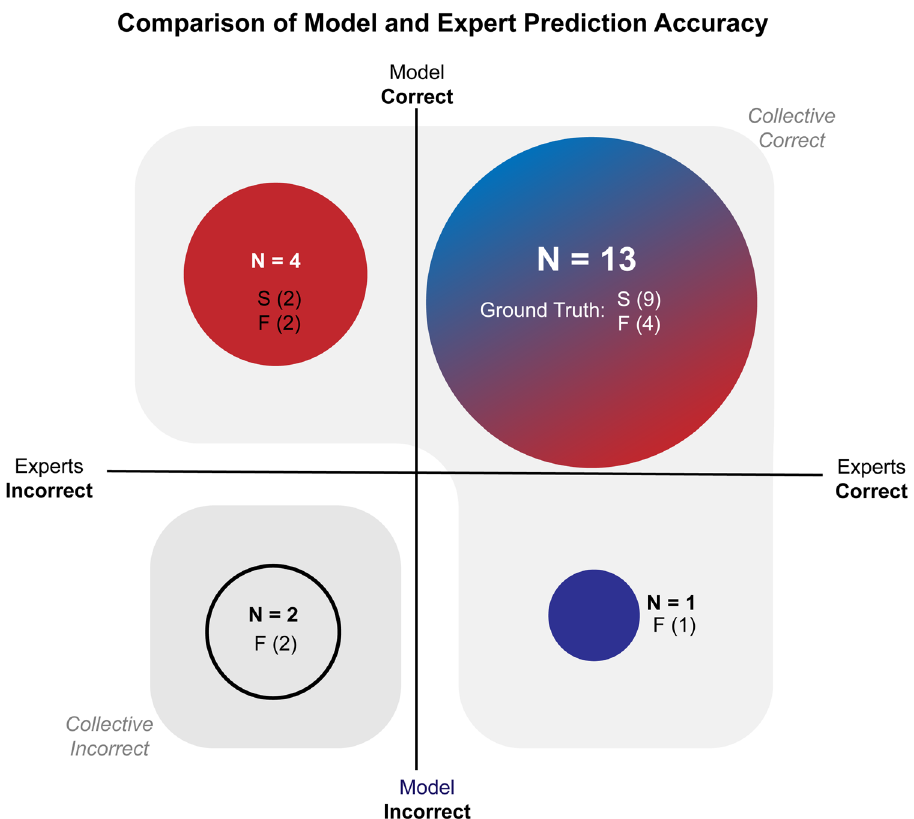
Figure 4. Outcome predictions of experts and SOCALNet. Outcomes of experts (Blue) and model (Red) in predicting task success using 1 min of video. Circle size denotes number of trials (N). Success (S) and failure (F) denoted underneath each N. When the union of successful predictions is taken, the model + expert grouping would successfully predict outcome in 18/20 cases. In the 2 remaining cases (bottom left quadrant), a critical error took place following the cessation of the video and was evaluated in subsequent counterfactual